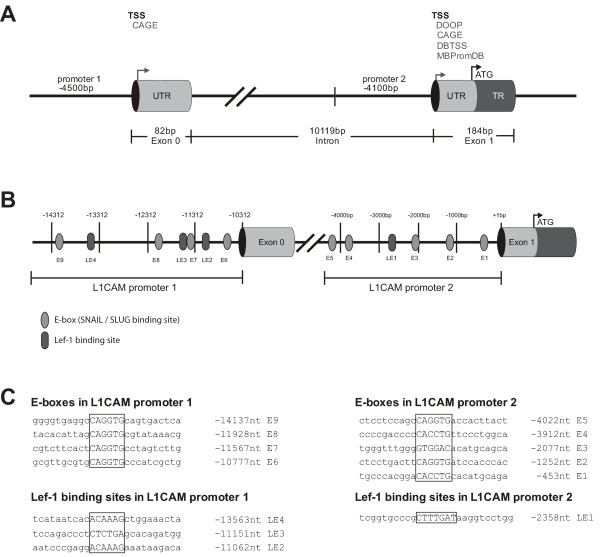
In silico characterisation of the L1CAM promoter. (A) Schematic illustration of the L1CAM promoter region according to the Ensembl database. Exon 1 contains the translational start codon (ATG) and a transcription start sites (TSS) predicted by the indicated databeses DOOP, CAGE, DBTSS, MBPromDB. The upstream sequence of appr. 4100 bp was identified as promoter 2. The non-coding Exon 0 (82 bp) is located appr. 10 kb upstream and is followed by an appr. 4.5 kb promoter region (promoter 1). A second TSS is predicted by the program CAGE. (B) Schematic illustration of E-boxes and TCF/LEF-1 binding sites in promoter 1 and promoter 2. (C) DNA sequences of E-boxes and Lef-1 transcription factor binding sites in promoter 1 and promoter 2.